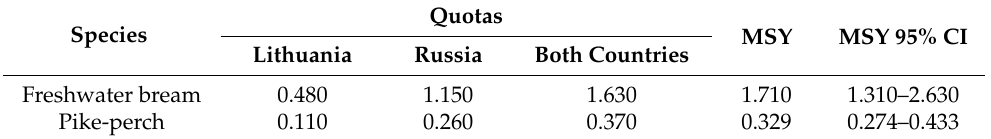
Table 7. Catch quotas for freshwater bream and pike-perch in 2021 and estimated MSY (in 10 3 tonnes). Quotas Species MSY MSY 95% CI Lithuania Russia Both Countries Freshwater bream 0.480 1.150 1.630 1.710 1.310–2.630 Pike-perch 0.110 0.260 0.370 0.329